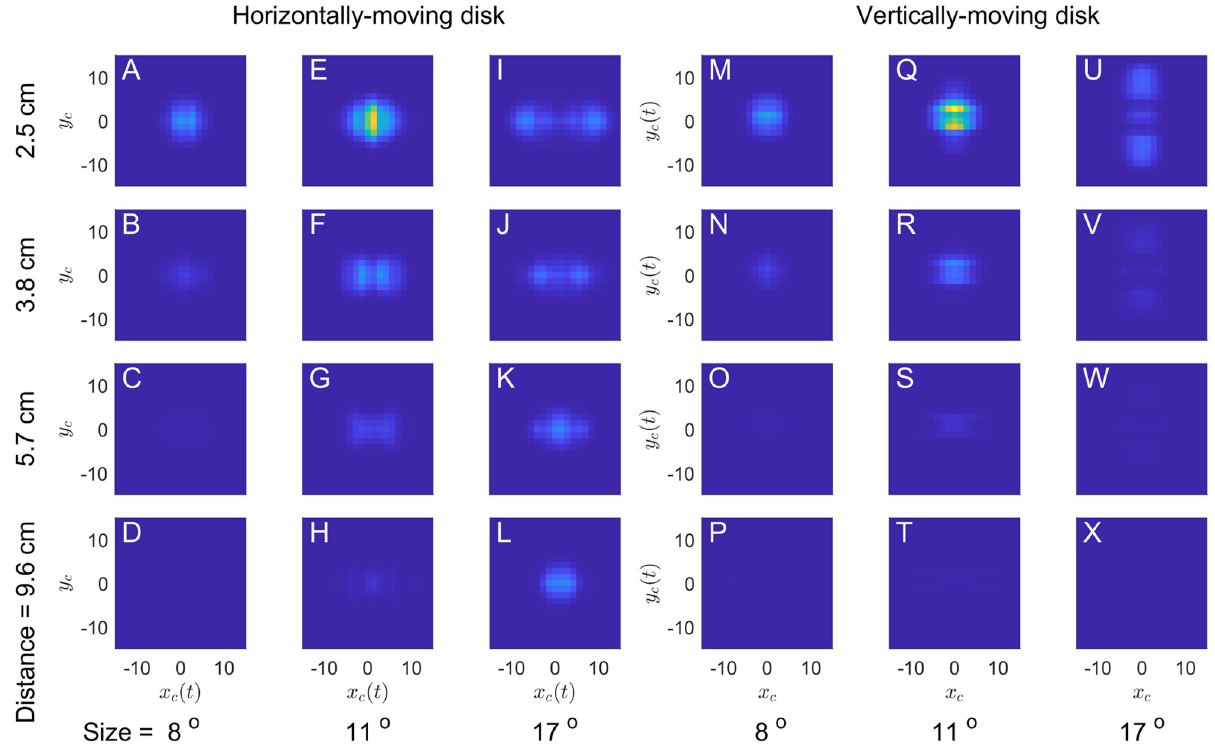
Fig 13. Model sensor output R ( x c , y c ) for horizontally or vertically travelling targets as they move across the centre of the field of view. Different rows are for different target distances, as indicated down the left-hand side of the figure, while different target sizes are in columns, as indicated along the bottom. The pseudocolour shows the instantaneous response of the disparity sensor as the centre of the moving target first reaches the location indicated by the (x,y) position. (To simulate the 60Hz refresh rate of the monitor, the target changes position every 16ms, and so stays in each location for five of the simulation’s 3.3ms timesteps). The color axis is the same in all 24